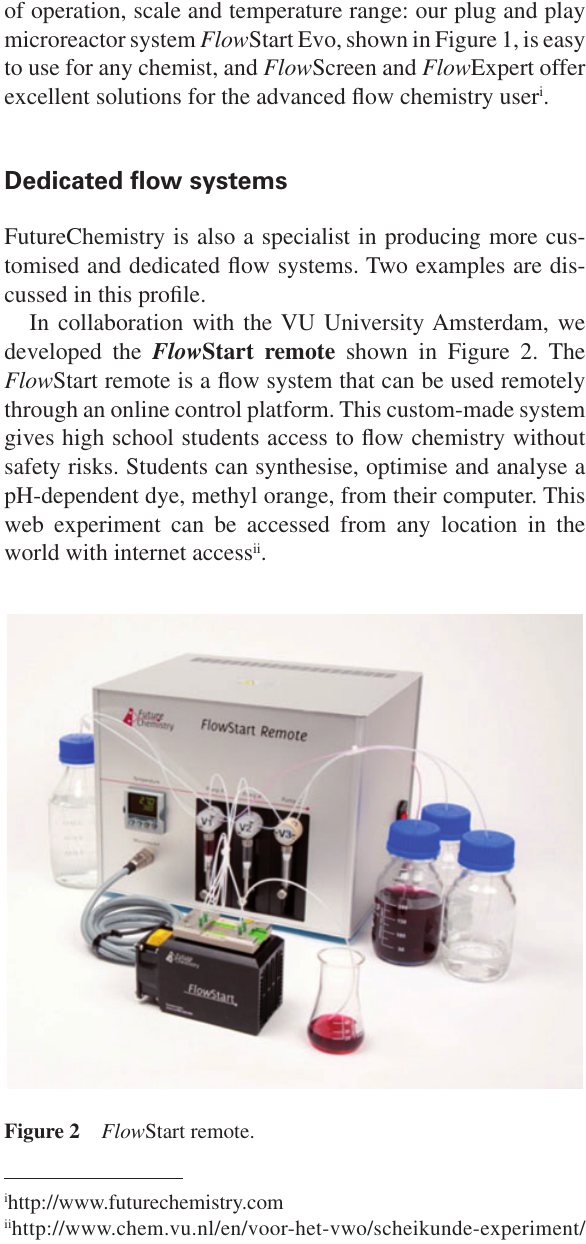
Figure 1 Photochemistry module with the FlowStart Evo.